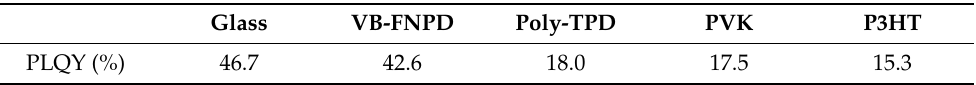
Table 2. Summary of photoluminescence quantum yield (PLQY) values of CsPbI 3 quantum dot (QD) films coated on a glass and different hole transporting layers